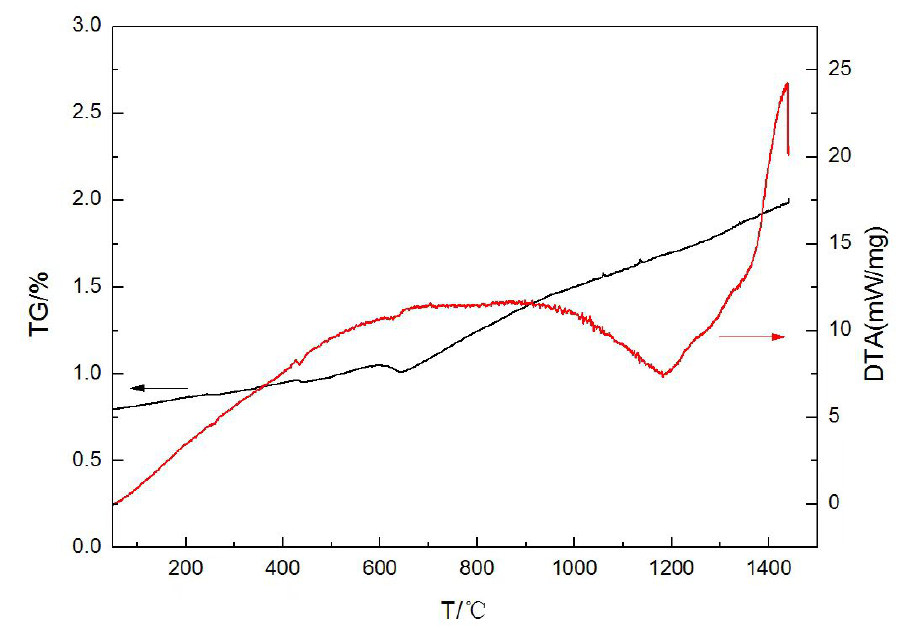
Figure 4. The DTA/TG curves of steel slag with Al 2 O 3 –SiO 2 system.